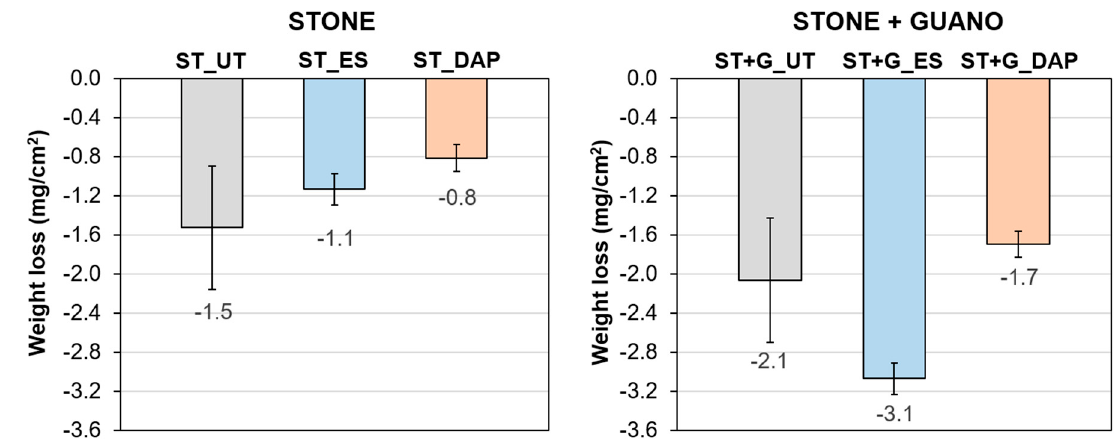
Figure 8. Weight loss after the abrasion test of untreated (“UT”) and treated (“ES” and “DAP”) stone (“ST”) and stone + guano (“ST + G”) specimens.